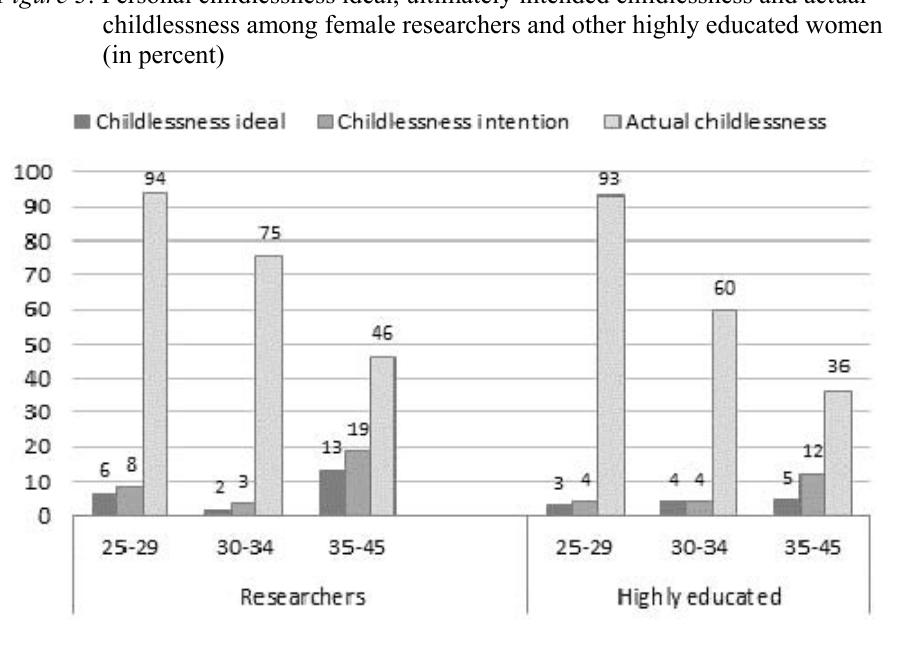
Figure 3 : Personal childlessness ideal, ultimately intended childlessness and actual childlessness among female researchers and other highly educated women (in